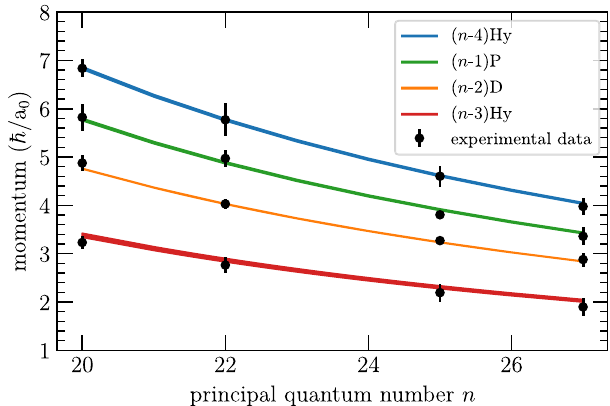
Fig. 6 Momenta resulting from state-changing collisions in dependence of the initial state. Depicted are the fi rst four peaks, deduced from the fi ts to the respective radial pro fi le (Fig. 5). The theoretically expected momenta are plotted as color-coded lines, where the thickness of the lines accounts for the momentum width (see text). The error bars indicate the momentum uncertainty as given by the fi t parameter σ of the Abel transform. Table 1 Relative population of the fi nal states down to the ( n − 4)Hy manifold and fraction of molecular ions Rb þ values are normalized to the sum of the detected atomic and molecular ions. The missing population is distributed over lower-lying